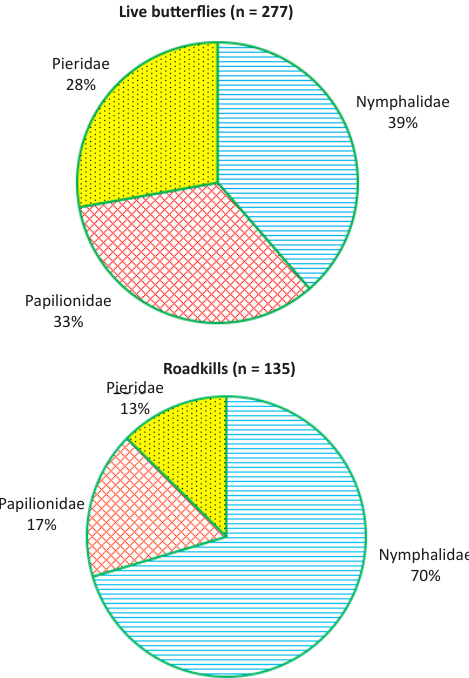
Figure 2. Composition of live and road-killed butterflies